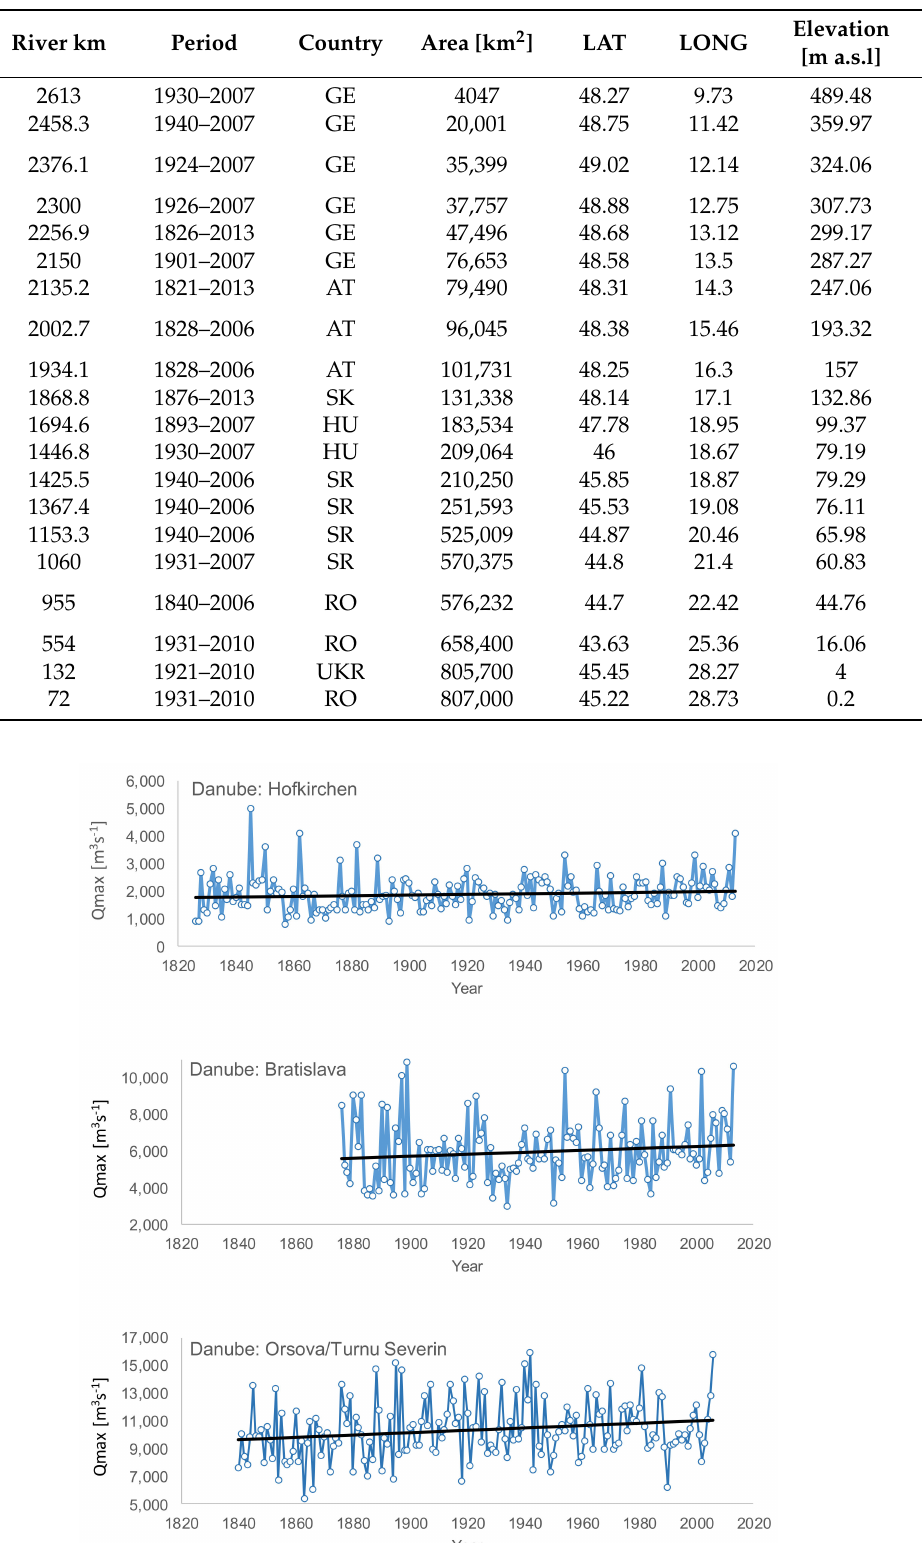
Table 1. List of the gauging stations along the Danube River. LAT: latitude; LONG: longitude; Q amax : long-term average of the maximum annual discharge.